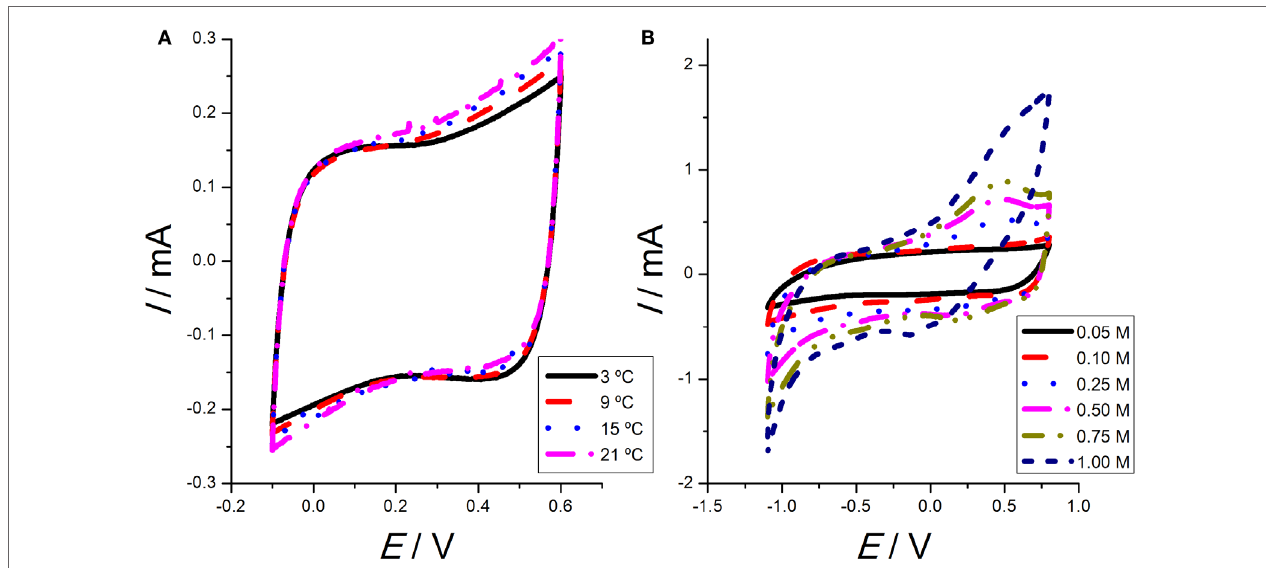
FiGURe 1 | (A) Second voltammetric responses obtained from SWCNTs films cycled between − 100 and 600 mV versus Ag/AgCl at 5 mV s − 1 , under different temperatures: 3, 9, 15, and 21°C in 0.1 M tetraethylammonium tetrafluoroborate (TEABF 4 ) aqueous solution. (B) Second voltammetric responses obtained from SWCNTs films cycled between − 1100 and 800 mV versus Ag/AgCl at 5 mV s − 1 at room temperature in aqueous solution with different concentrations of TEABF 4 (0.05, 0.10, 0.25, 0.50, 0.75, and 1.00M). Reproduced from Martinez et al. (2012), with permission from